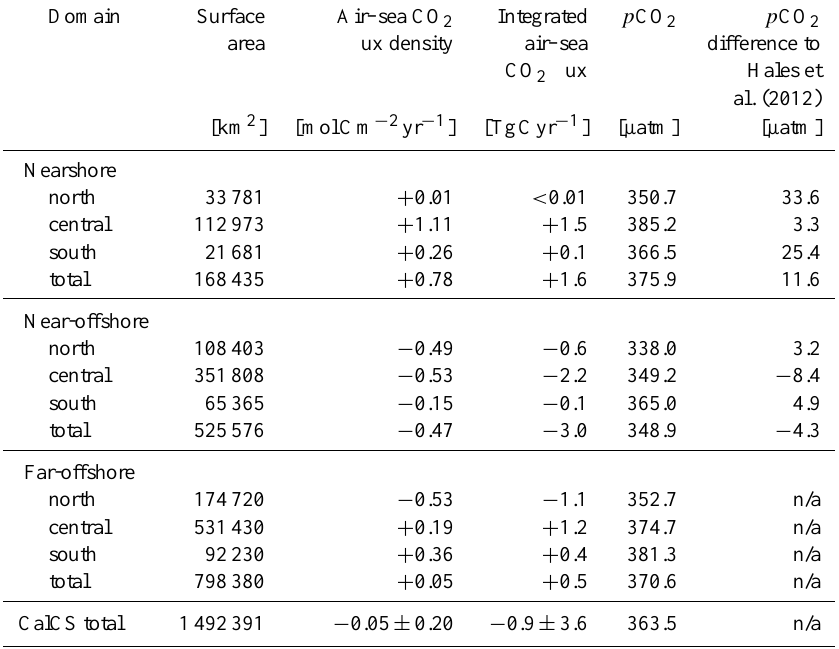
Table 3. Regional variability of annual mean surface p CO 2 and air–sea CO 2 fluxes in the CalCS. The p CO 2 difference in the last column is p CO 2 from our study minus p CO 2 from Hales et al.